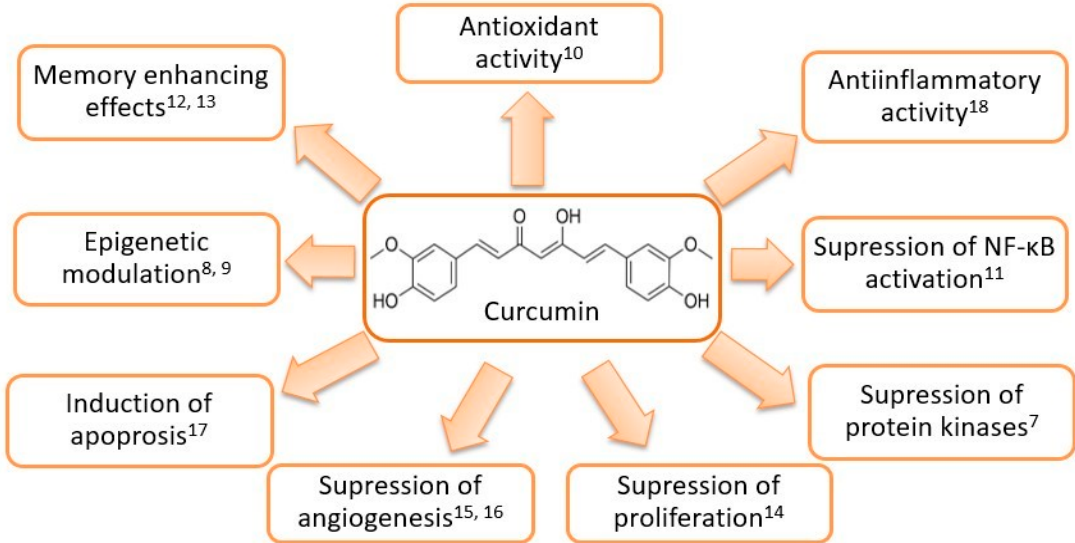
Figure 1. Structural formula and reported biological effects of curcumin [7–18].